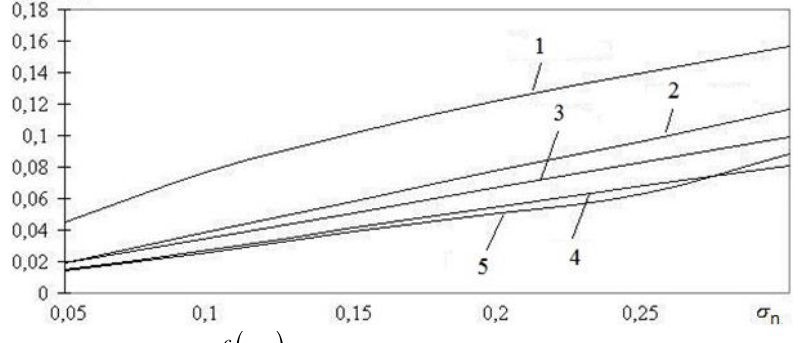
  m f  for various processing methods (1 – exponential method, 2 – MSD n weighted mean method, 3 – median method, 4 – moving average method, 5 – method